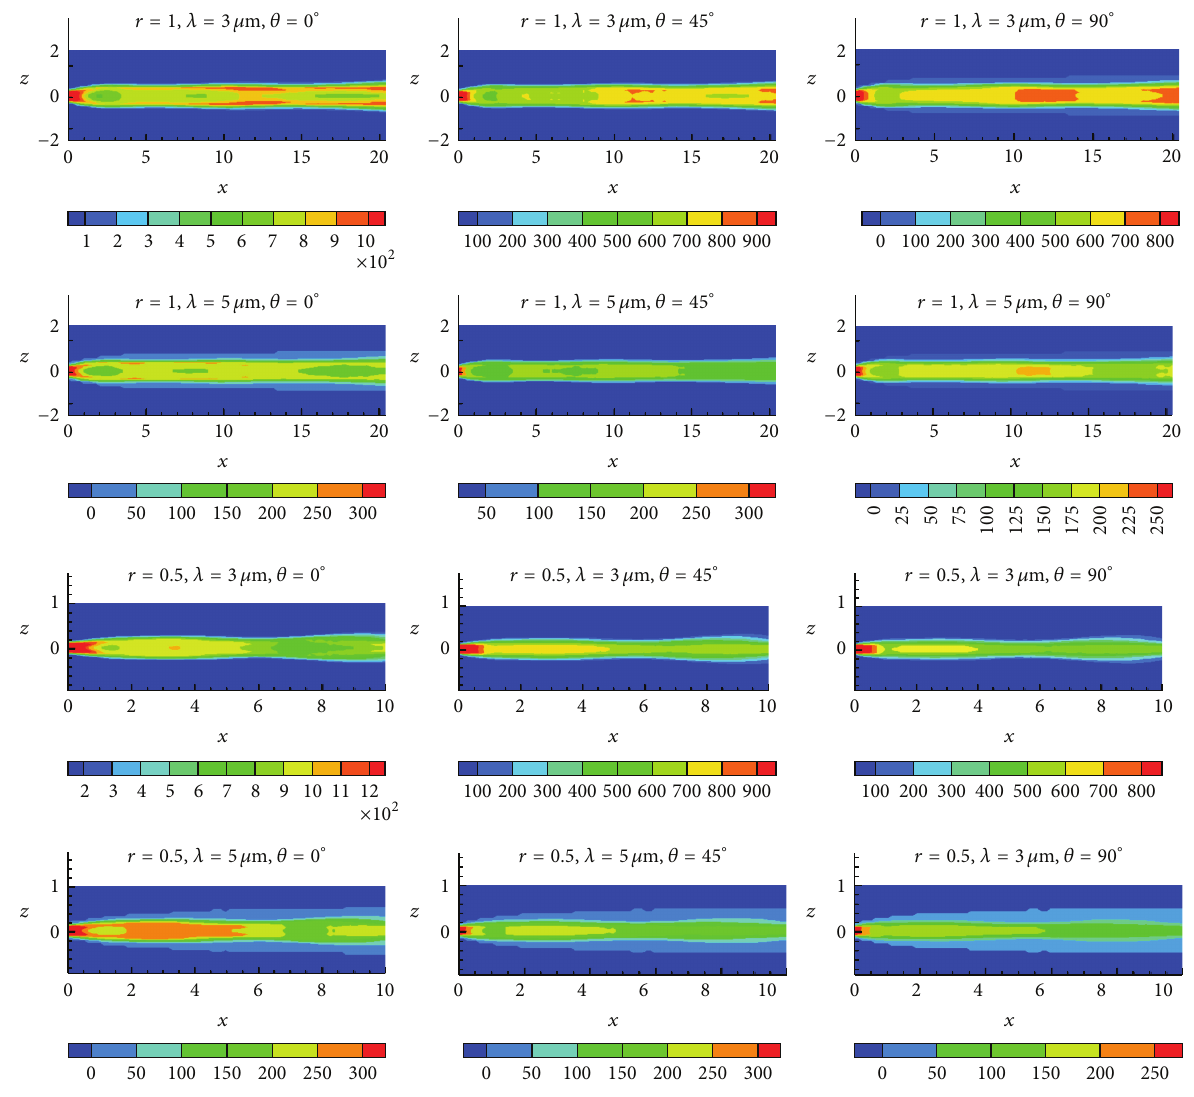
Figure 12: Map of spectral radiance on 𝑥 - 𝑧 coordinate